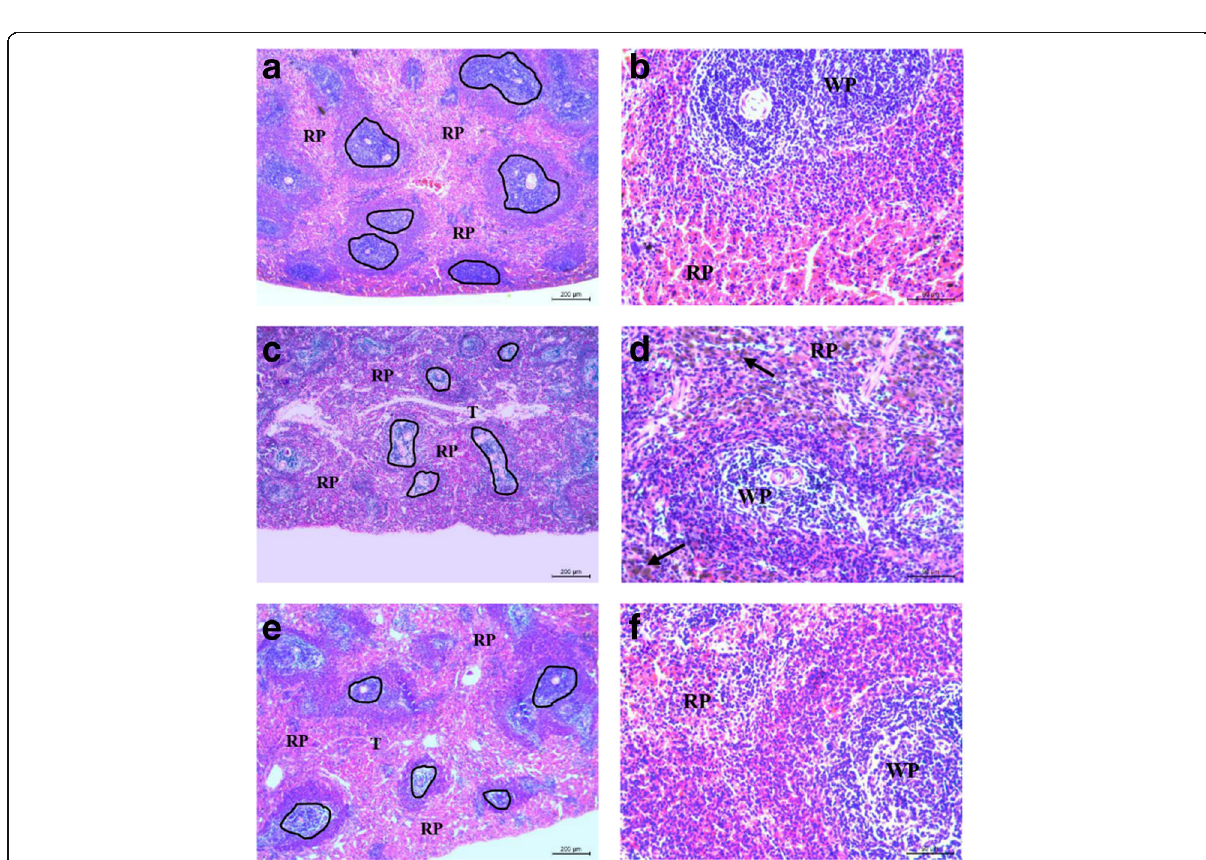
Fig. 7 The toxicity effects of MTX and MTX-CS NGs on the rats ’ spleen. H&E stained spleen excised from mice following 14 days treatment after seven intraperitoneal injections. a , b Sections of the control group. c , d The MTX-treated group. e , f The MTX-CS NG-treated